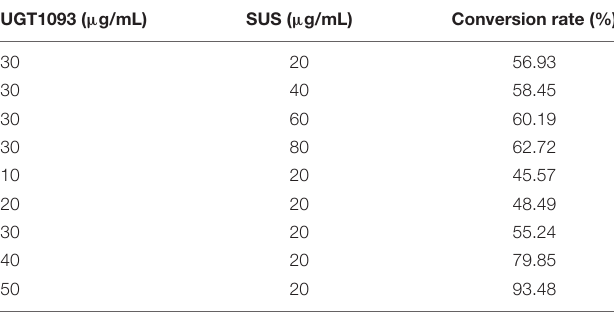
TABLE 2 | Enzyme on the conversion rate of GA-glycosylated products*.